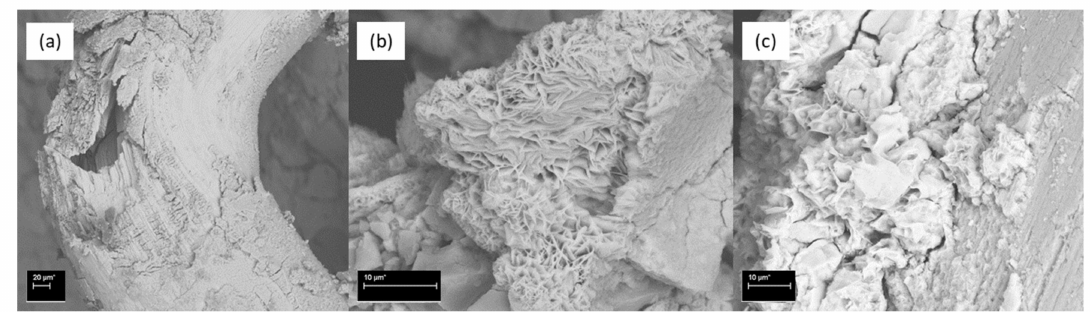
Figure 13. The steel fibres in broken pieces, from ( a ) M3C-F2, ( b ) M3Cl-F2, and ( c )